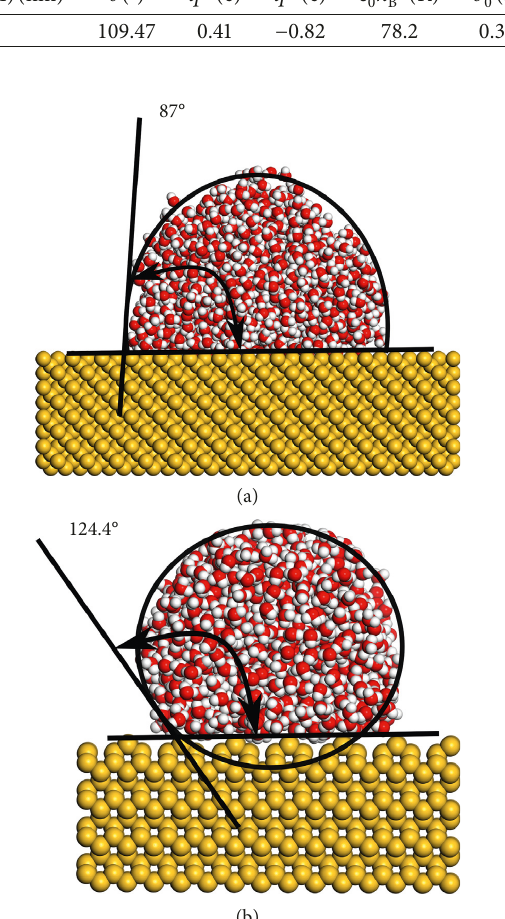
Figure 12: Simulation diagram of contact angle: (a) normal sur- face; (b) grating structure.